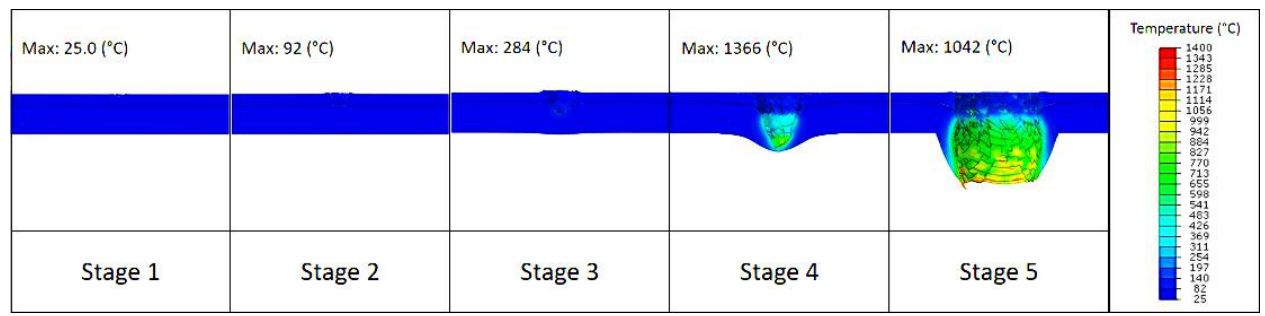
Figure 24. Plastic strain for friction drill joining of AISI304/Al6061, at different stages.